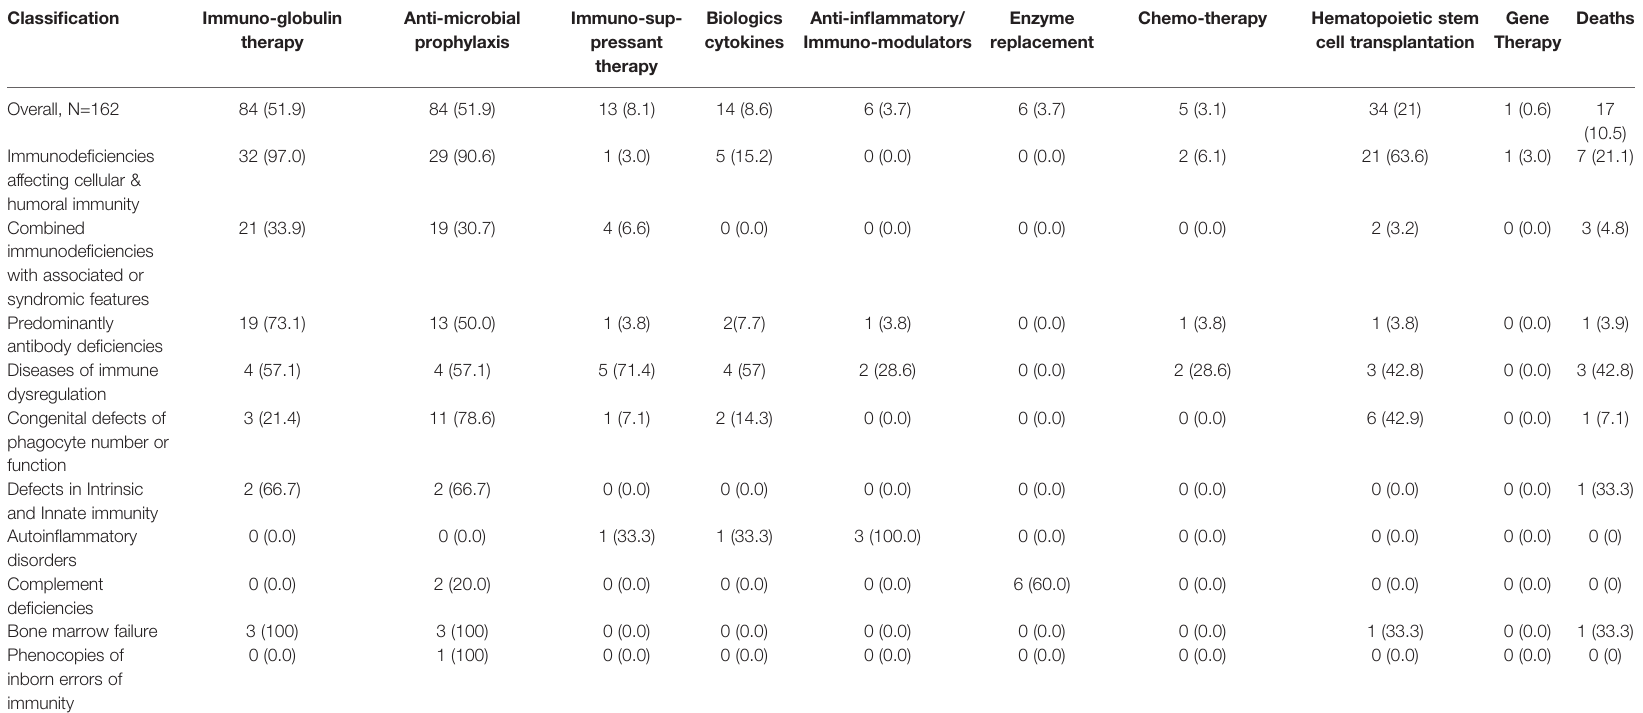
TABLE 6 | Treatment modalities and mortality within IEI